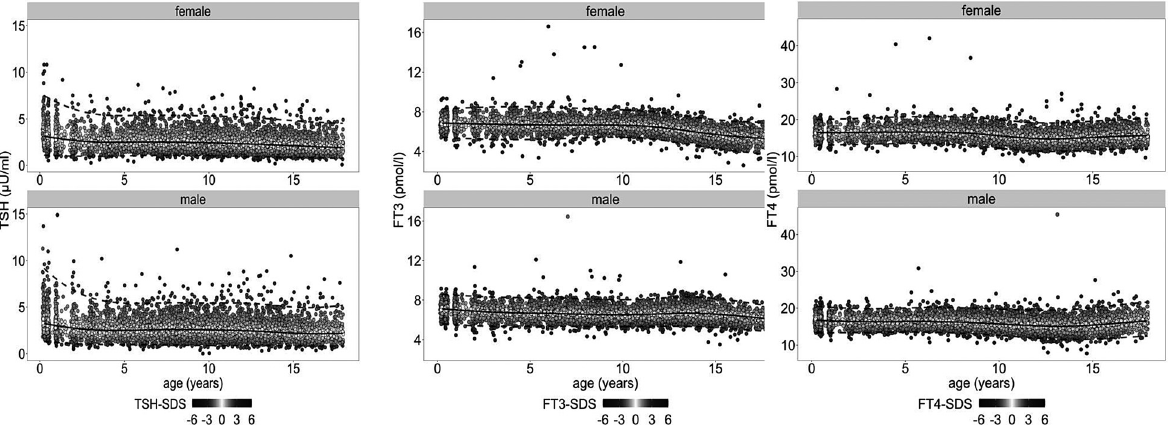
Figure 2: Reference percentiles for TSH, FT3, and FT4 by age and sex. The2.5th(dashedline),50th(solidline),and97.5th(dashedline)percentilesformalesandfemalesareshownforTSH(A),FT3(B),andFT4(C). TheintensityoftheshadingofthehormoneleveldatapointsforthereferencecohortindicatestherelativehormoneSDSvalue.SDS,standard deviation score. With permission from ref.